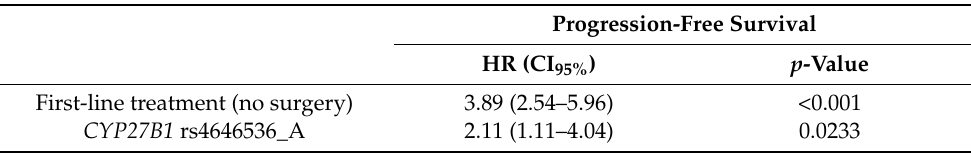
Table 4. Influence of gene polymorphisms and clinical characteristics on progression-free survival of 194 NSCLC patients.